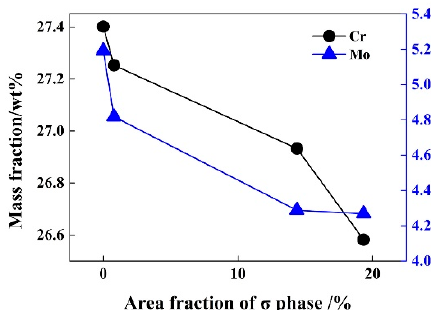
Figure 5. The relationship between the area ratio of the σ phase and the mass fraction of Cr and Mo in ferrite.